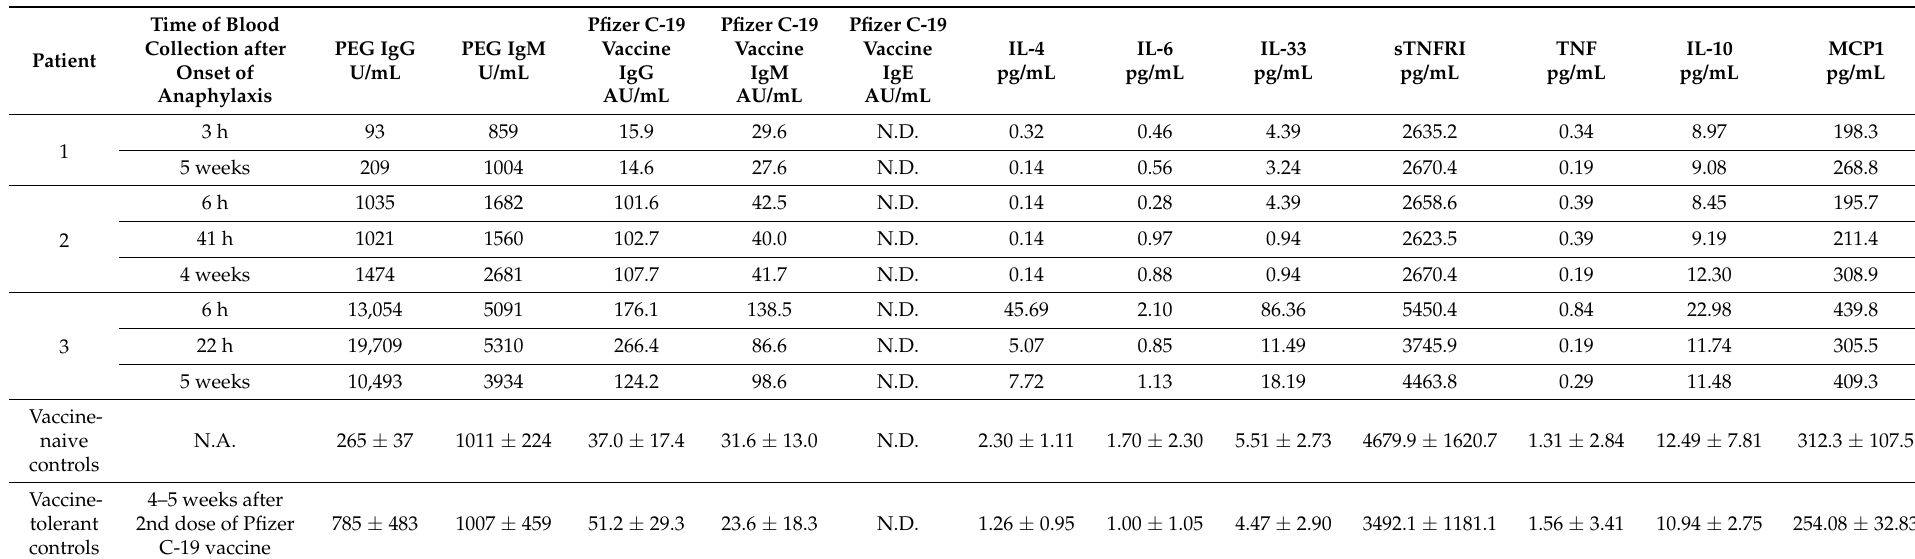
Table 2. Immunological findings of patients 1–3 and